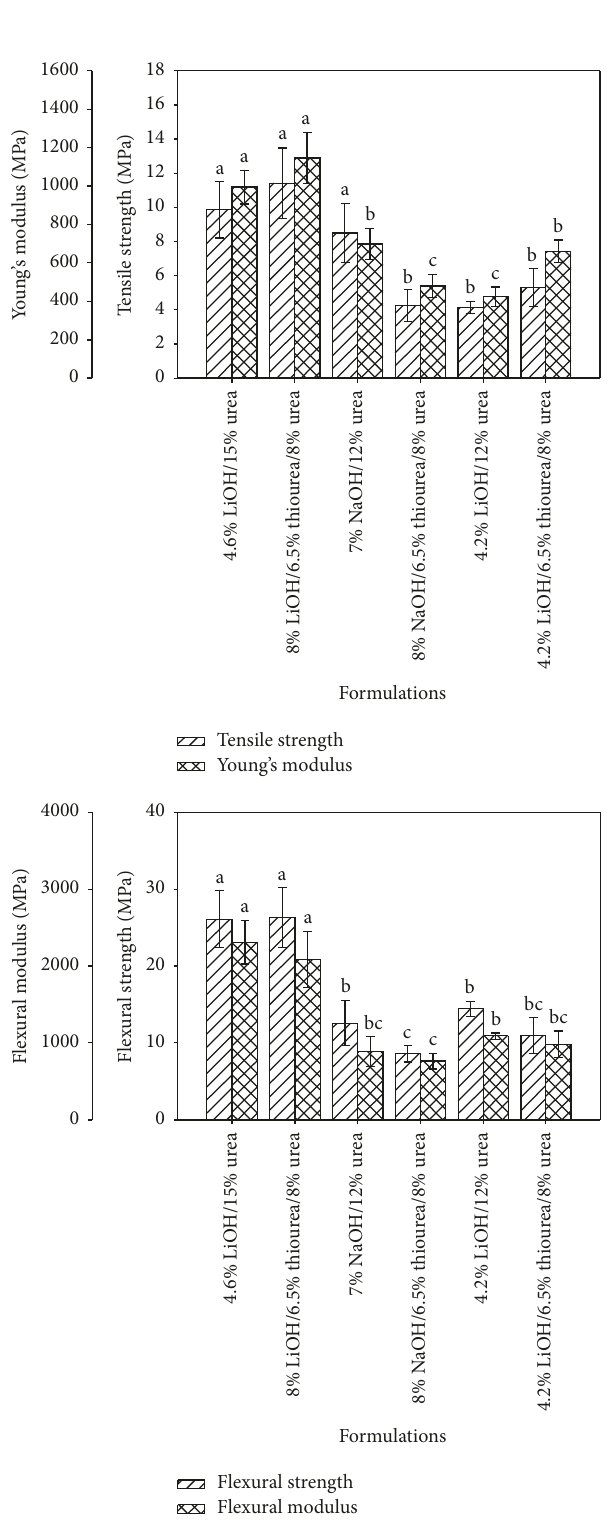
Figure 5: Effect of various alkaline aqueous solvent formulations on the mechanical properties of panels composed of 25% cotton: 75% OOW/AF. Treatment values with different letters for the same mechanical test are significantly different ( 𝑝 ≤ 0.05 ) following Duncan’s Multiple Range Test